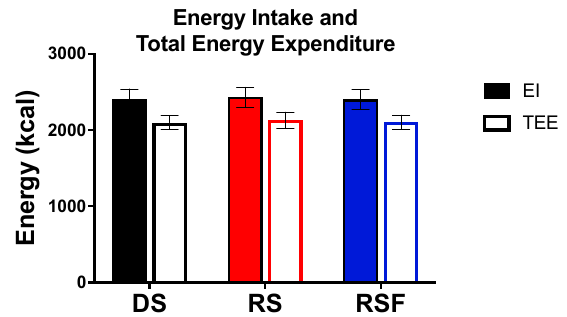
Figure 1. Energy Balance. Energy intake (EI) and total energy expenditure (TEE) during 24 h whole room indirect calorimetry consuming digestible starch (DS), resistant starch (RS), or resistant starch with high fiber (RSF). There are no differences between groups. Data are expressed mean ± SEM.